Question: Provide a one-line summary of what is displayed.
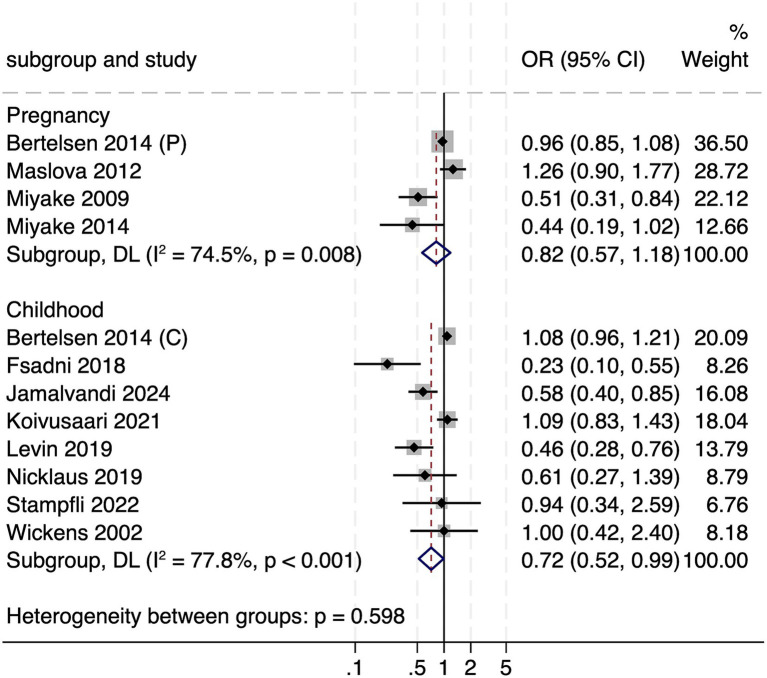
Answer: Forest plot of subgroup analysis by timing of exposure.